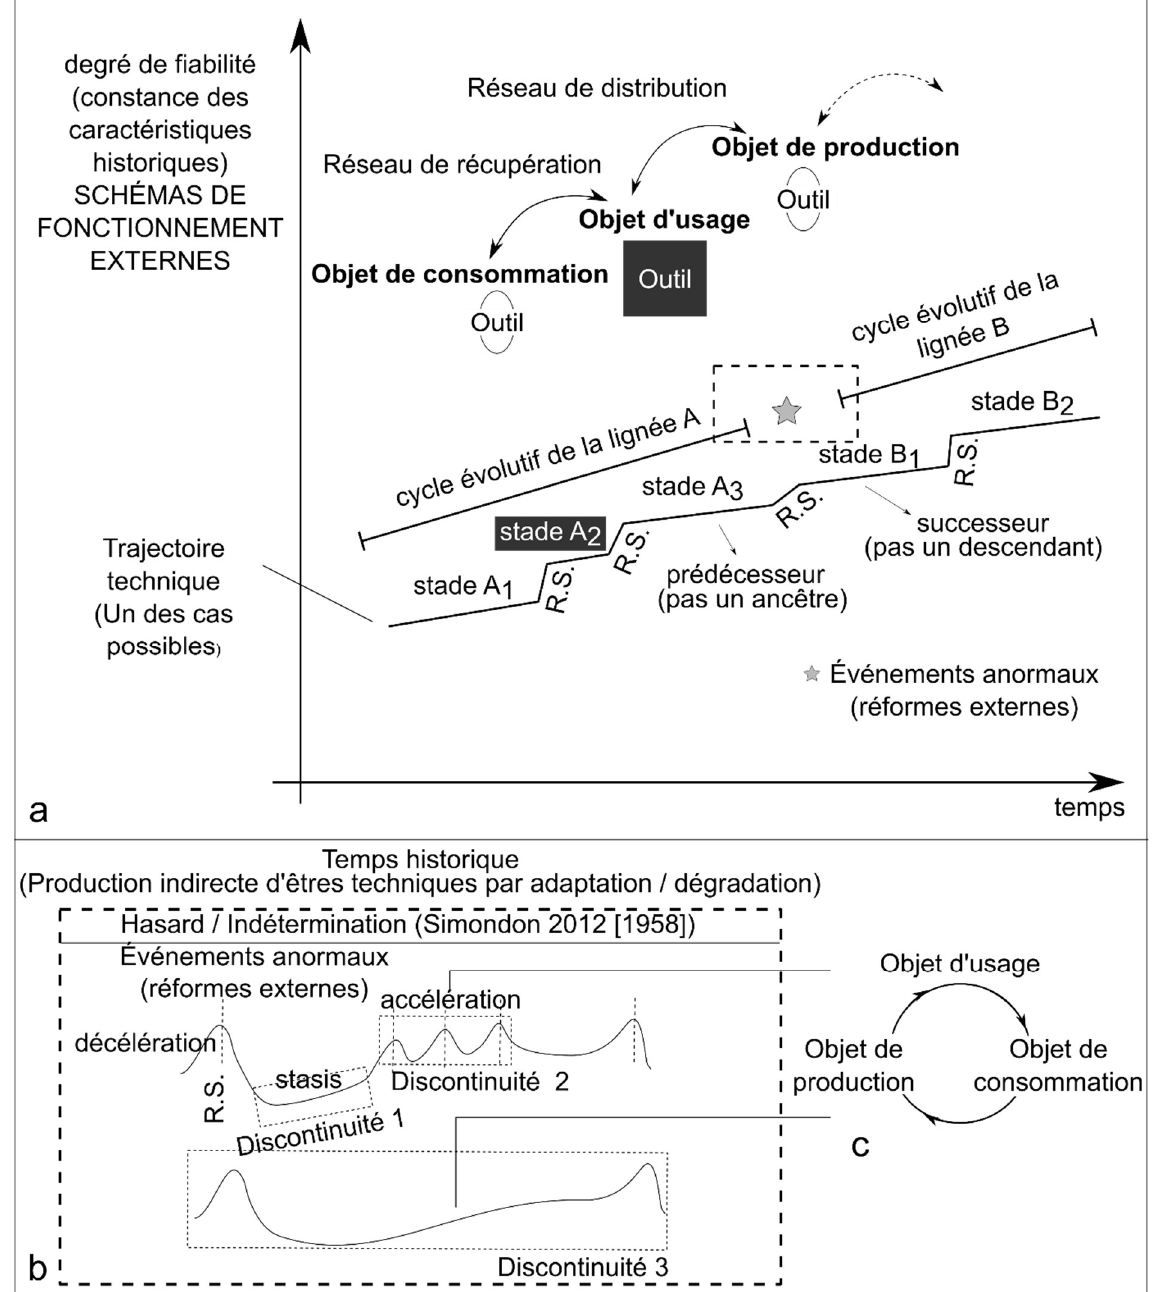
Figure 15. Structure des trajectoires techniques préhistoriques: (a) définition générale, (b) rôle du hasard dans les transformations internes, (c) transformations psychosociales des